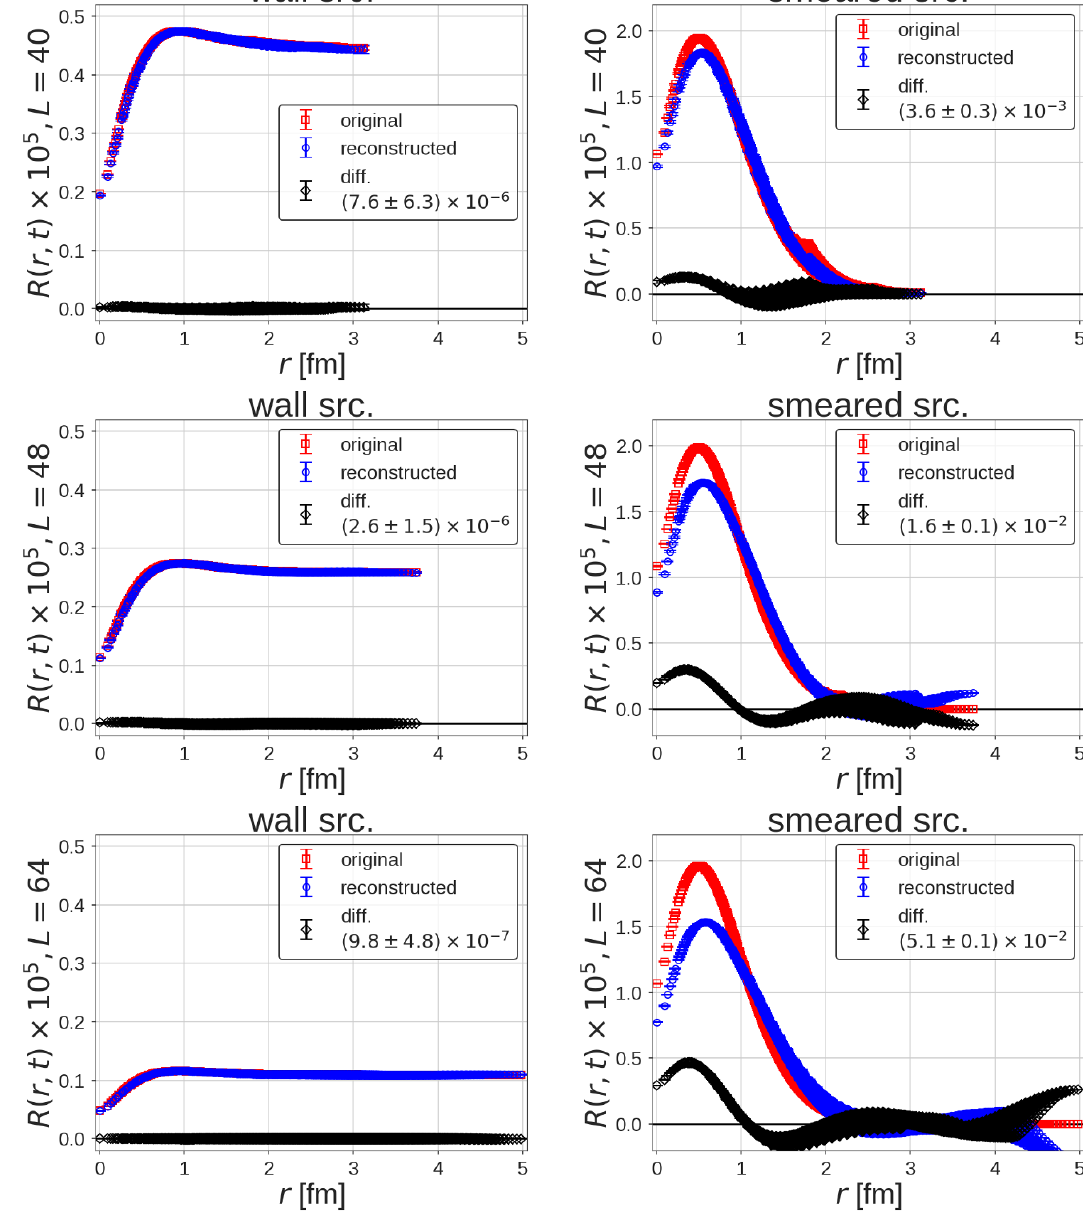
Figure 14 . Comparisons between the original R -correlator (red squares) and the reconstructed R -correlator using low-lying eigenstates below the inelastic threshold (blue circles) at t=a = 13 for L = 40 (top), 48 (middle), 64 (bottom). The di(cid:11)erences between the two R -correlators are shown by black diamonds and the values for the corresponding residual norms are given in legend panels. (Left) The wall source. (Right) The smeared source.